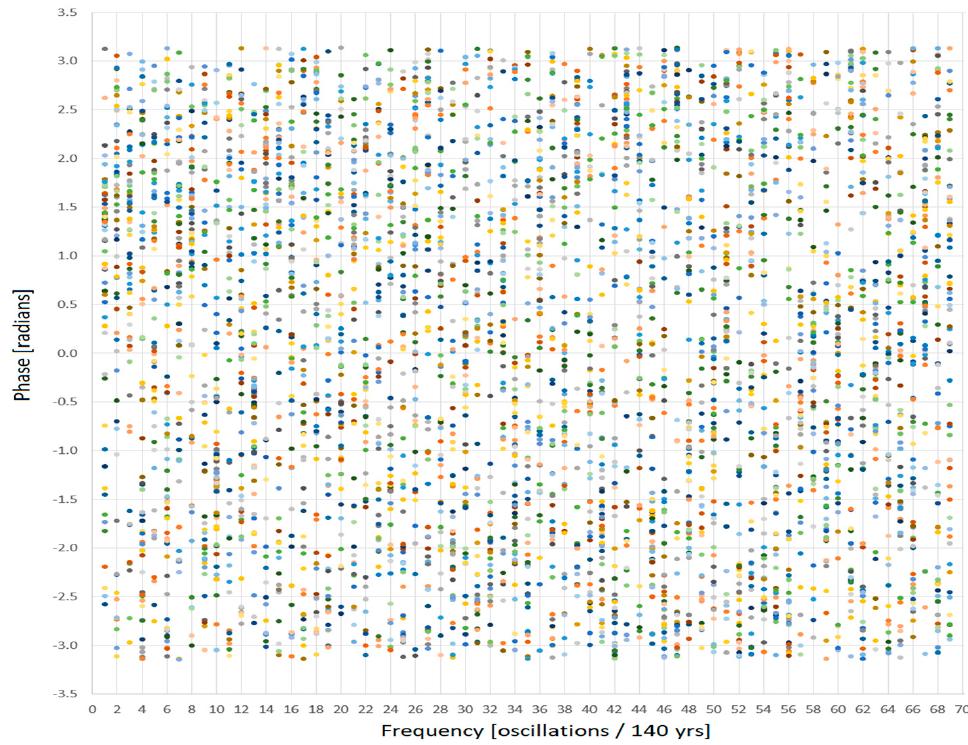
Figure 3. Phase of periodic signals for all 60 sites (refer to caption of Figure 2). This phase is cyclic in nature; the value − 3.14 is equivalent to +3.14, and the distance between − 3.0 and 2.7 is only 0.58 radian, not 5.7 radians.